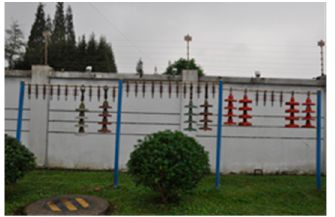
Figure 12. The CBS substation site testing point.